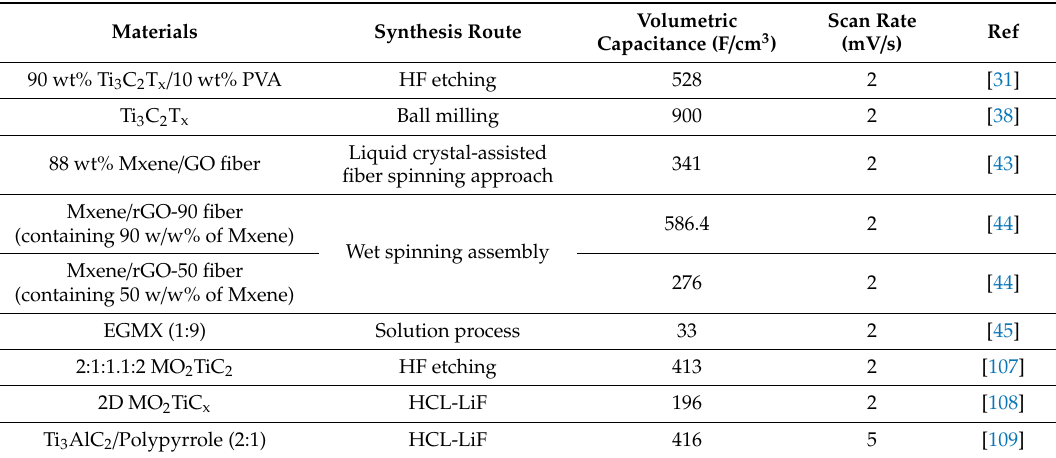
Table 3. Summary of the capacitance of MXene and their